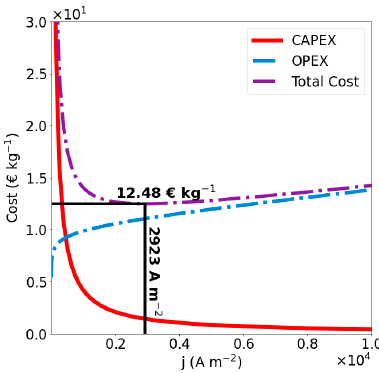
Figure 8. Investment cost (CAPEX), operating cost (OPEX), and Cost function for an electrochemical cell with ℎ (cid:3009) = ℎ (cid:3016) = 1.5 mm, 𝐻 (cid:3032)(cid:3039)(cid:3032)(cid:3030) = 10 cm, 𝑝 = 1 bar, 𝑇 = 353 K, 𝑌 = 0.30, 𝑏 (cid:3028)(cid:3041) = 0.15 V dec − 1 , (cid:3118) (cid:3118)